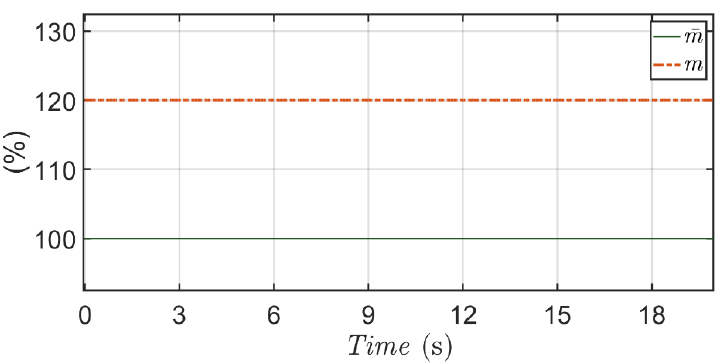
Figure 12. A fixed positive perturbation (20% of m ) is added for m in Scenario 2.